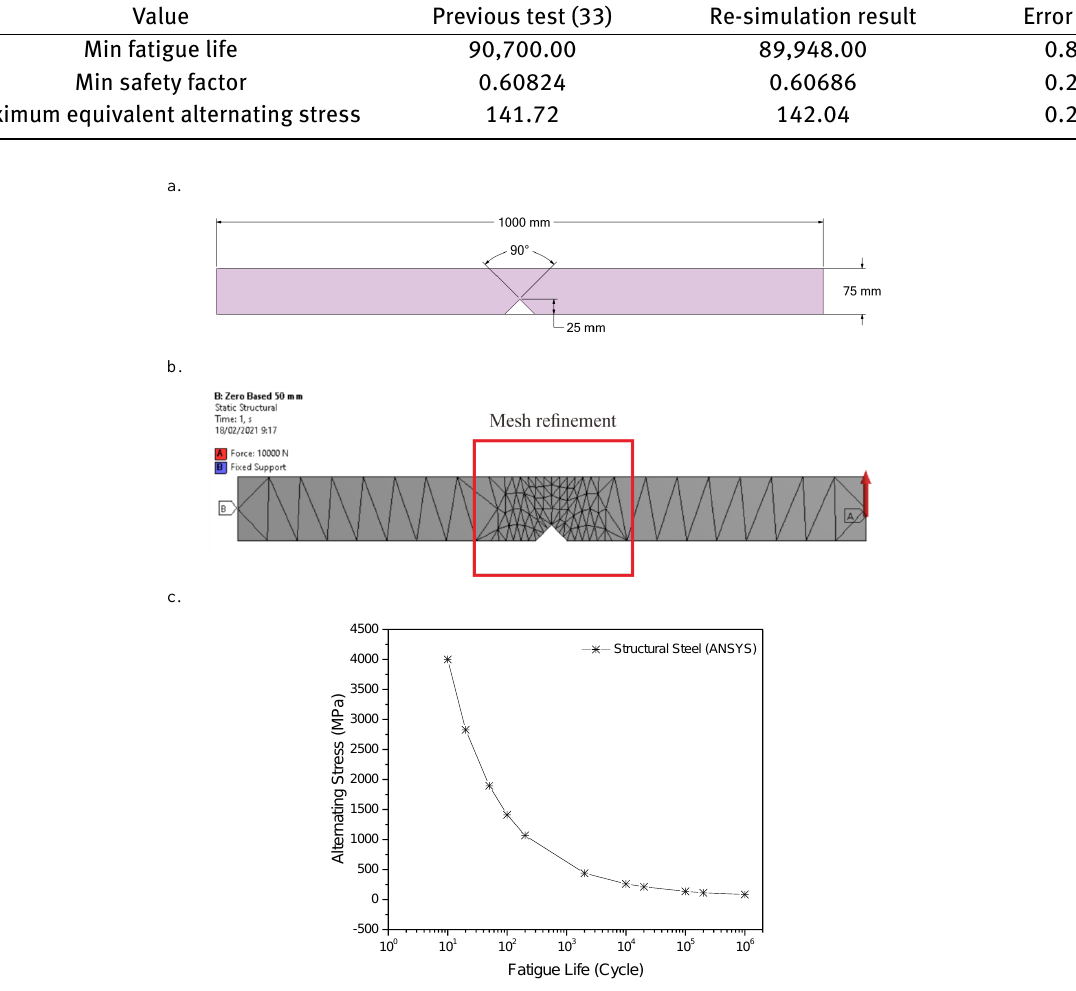
Figure 8. a. Cantilever Beam Design [33]; b. Boundary Condition; c. S–N Curve of Structural Steel (ANSYS) Figure 8: a. Cantilever beam design [34]; b. Boundary condition; c. S–N curve of structural steel (ANSYS)